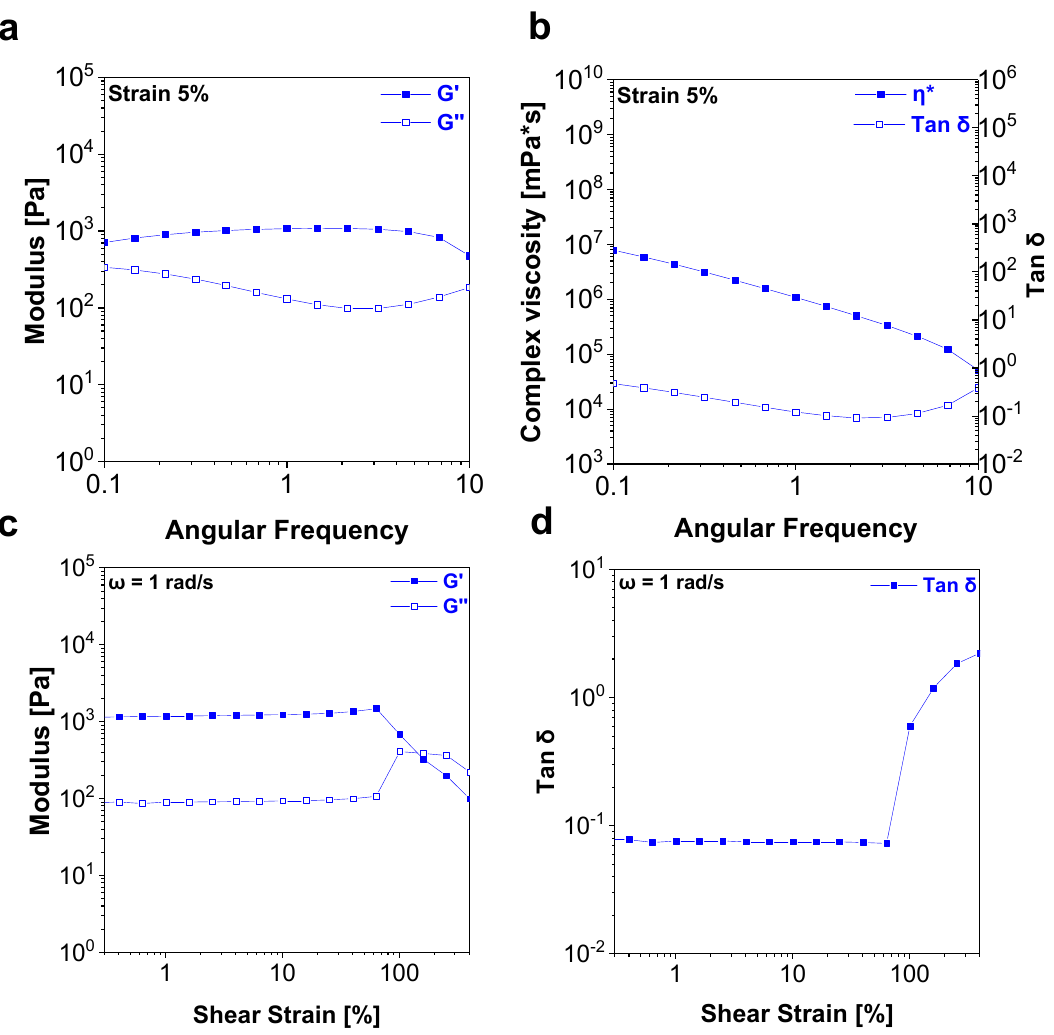
Figure 3. Rheological characterization of the new PAA-based self-healing hydrogel. ( a , b ) Frequency sweep and ( c , d ) amplitude sweep.